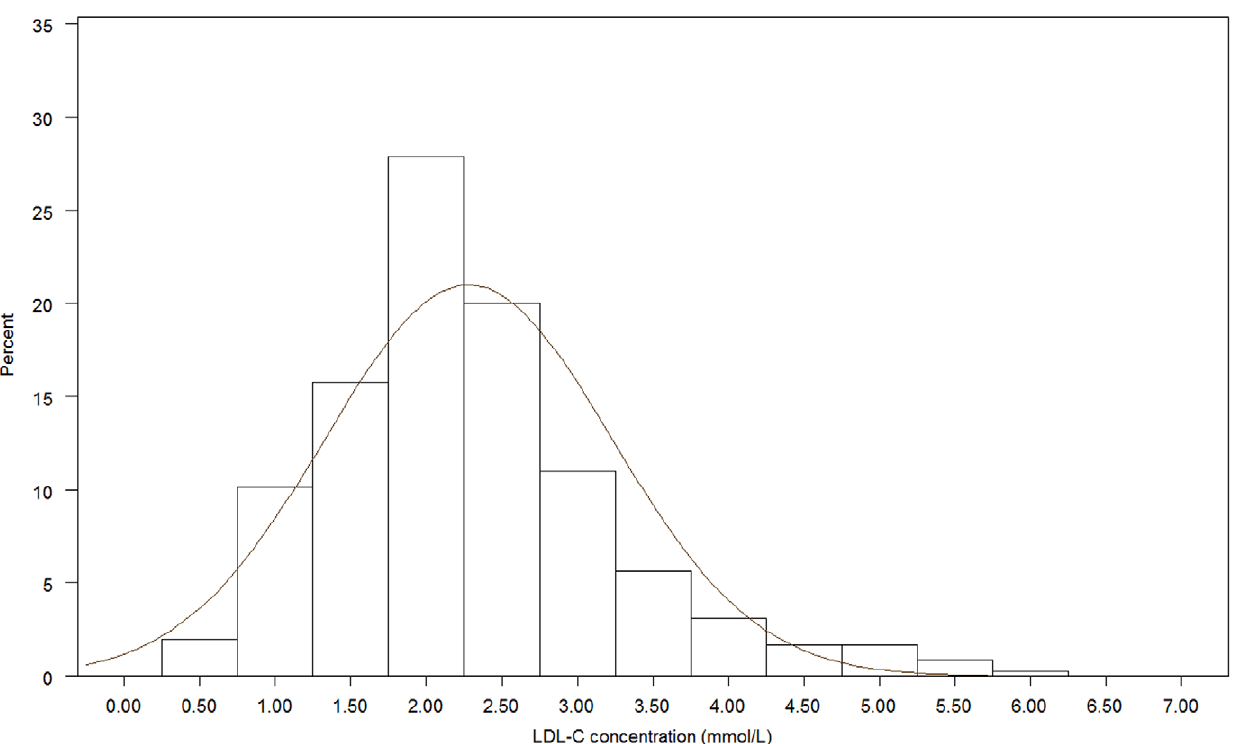
Figure 4. Histogram for the LDL-C values in patients on rosuvastatin.